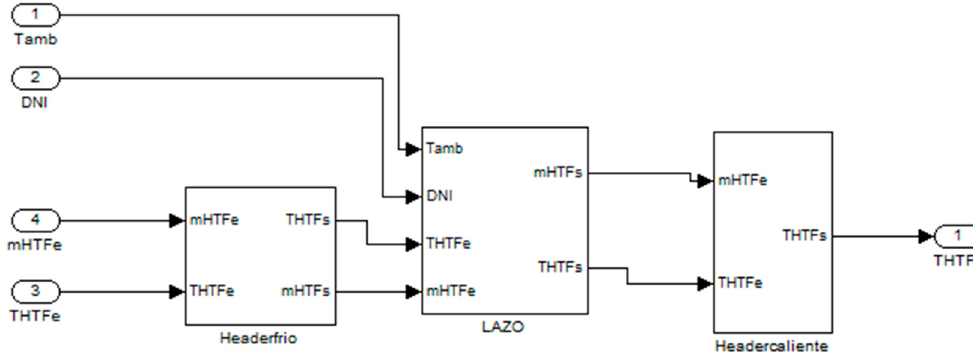
Figure 3. Solar field dynamic model.